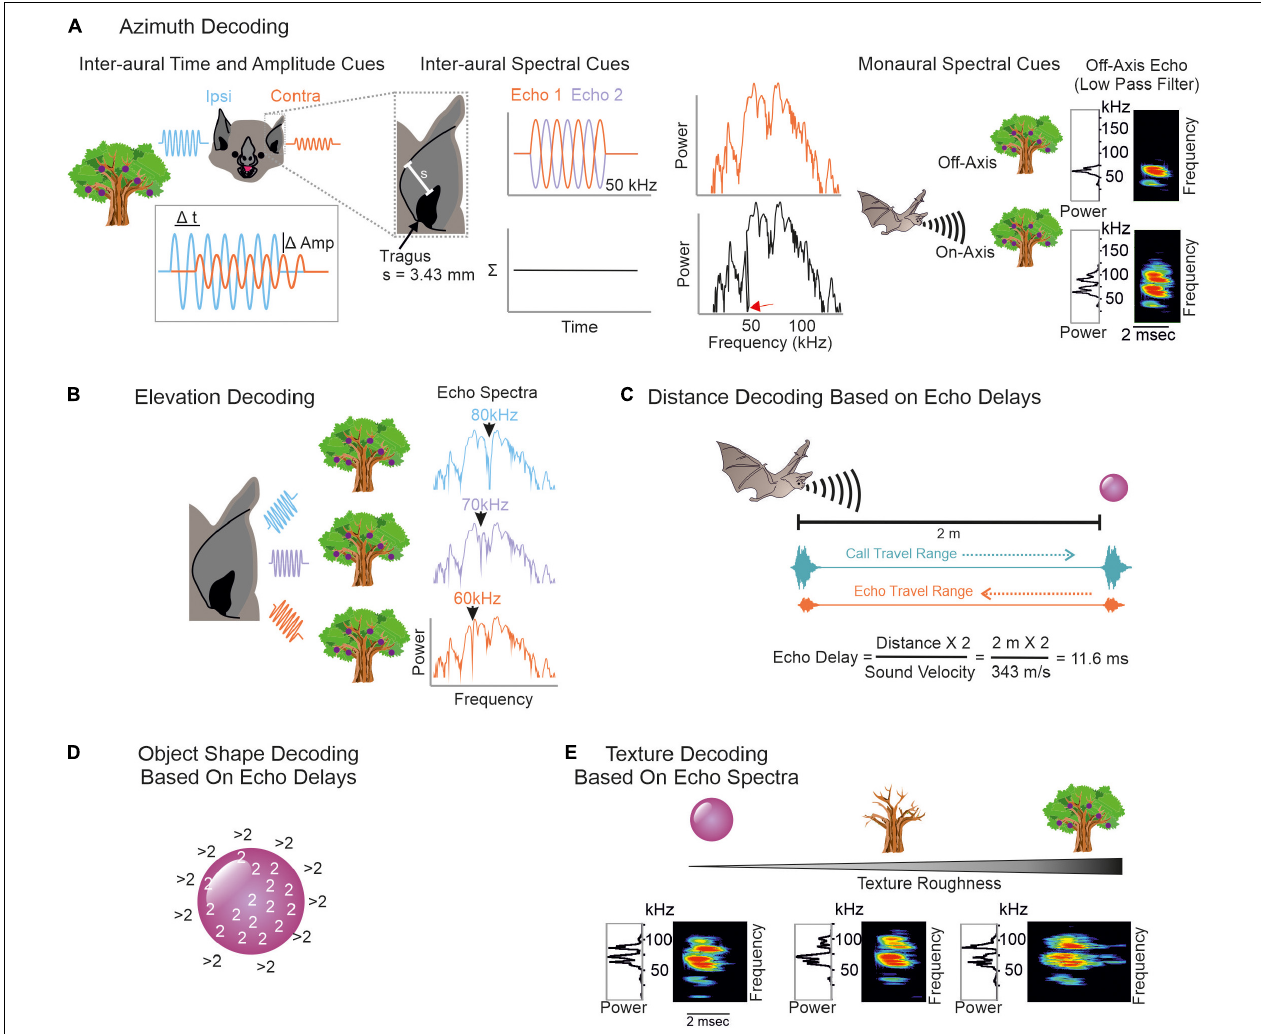
FIGURE 2 | Overview on decoding spatial information from echoes. (A) To infer an object’s azimuth, bats can use inter-aural amplitude, time ( left ), and spectral cues ( middle ), but also monaural spectral cues ( right ). Ipsilateral echoes ( blue waves ) are higher in amplitude ( Amp ) and reach the ipsilateral ear earlier than the contralateral ear ( orange waves ). Contralateral echoes bypass the bat’s head which creates spectral notches due to multiple reflections. To understand how spectral notches are generated, we assume that the echo gets reflected off the bat’s pinna. This evokes a second echo that temporally overlaps with the first echo. By assuming a pinna-tragus distance of 3.43 mm and considering that the second echo travels back to the tragus, sound waves with a wavelength of 6.86 mm (or 50 kHz) are phase shifted by 180 ◦ between both echoes. This creates a spectral notch at 50 kHz ( red arrow in black power spectrum). Based on characteristic spectral notches, contralateral echoes are discriminable from ipsilateral ones. Because of the frequency dependent directionality, echoes from off-axis objects mainly contain low frequency portions. Echoes from on-axis objects additionally contain high frequency portions (Surlykke et al., 2009a; Simmons, 2012, 2014; Wohlgemuth et al., 2016b). (B) Elevation decoding is based on elevation-dependent spectral-notches in the echoes. (C) Target distance is computed based on echo-delays. Both call and echo travel the distance between the bat and the object at sound velocity. This leads to distance-dependent echo delays to which